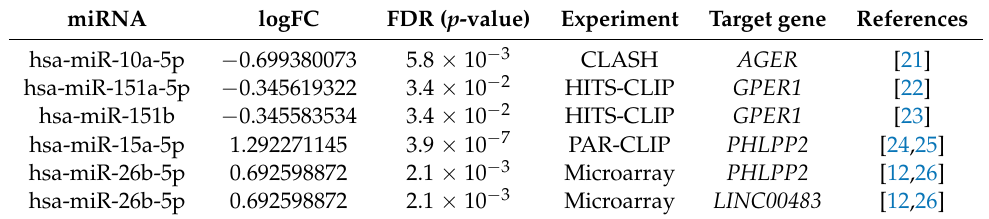
Table 2. Differentially expressed miRNAs in Alzheimer’s Disease (AD) targets differentially expressed genes in